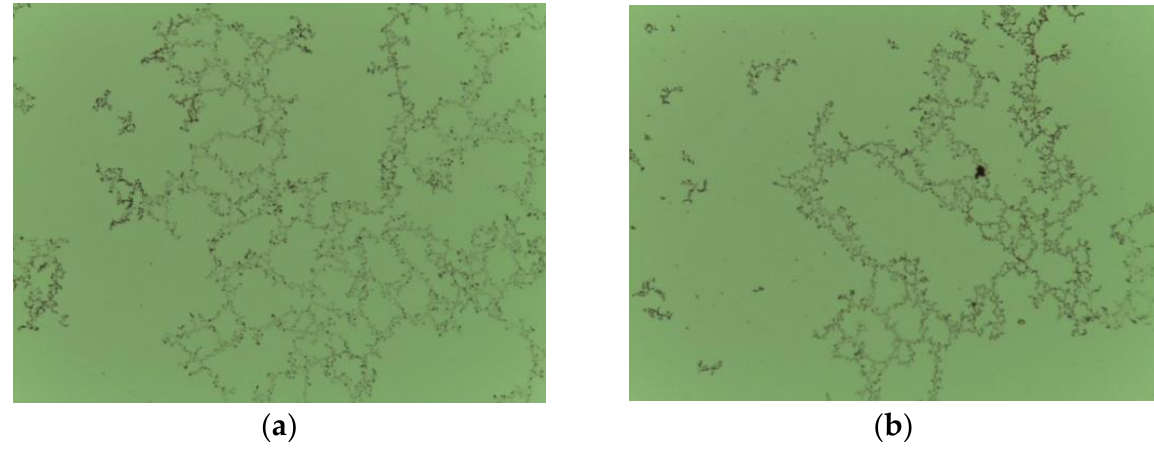
Figure 8. Photomicrographs of flocculant chains fully expanded without SHMP ( a ) and fragmented in small flocculant coils in the presence of SHMP ( b ), both at pH 9 in seawater.